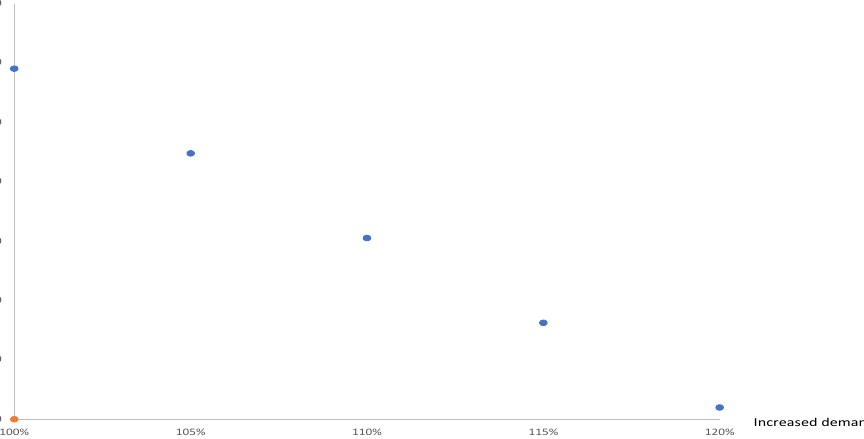
Figure 6. Water surplus production versus increased